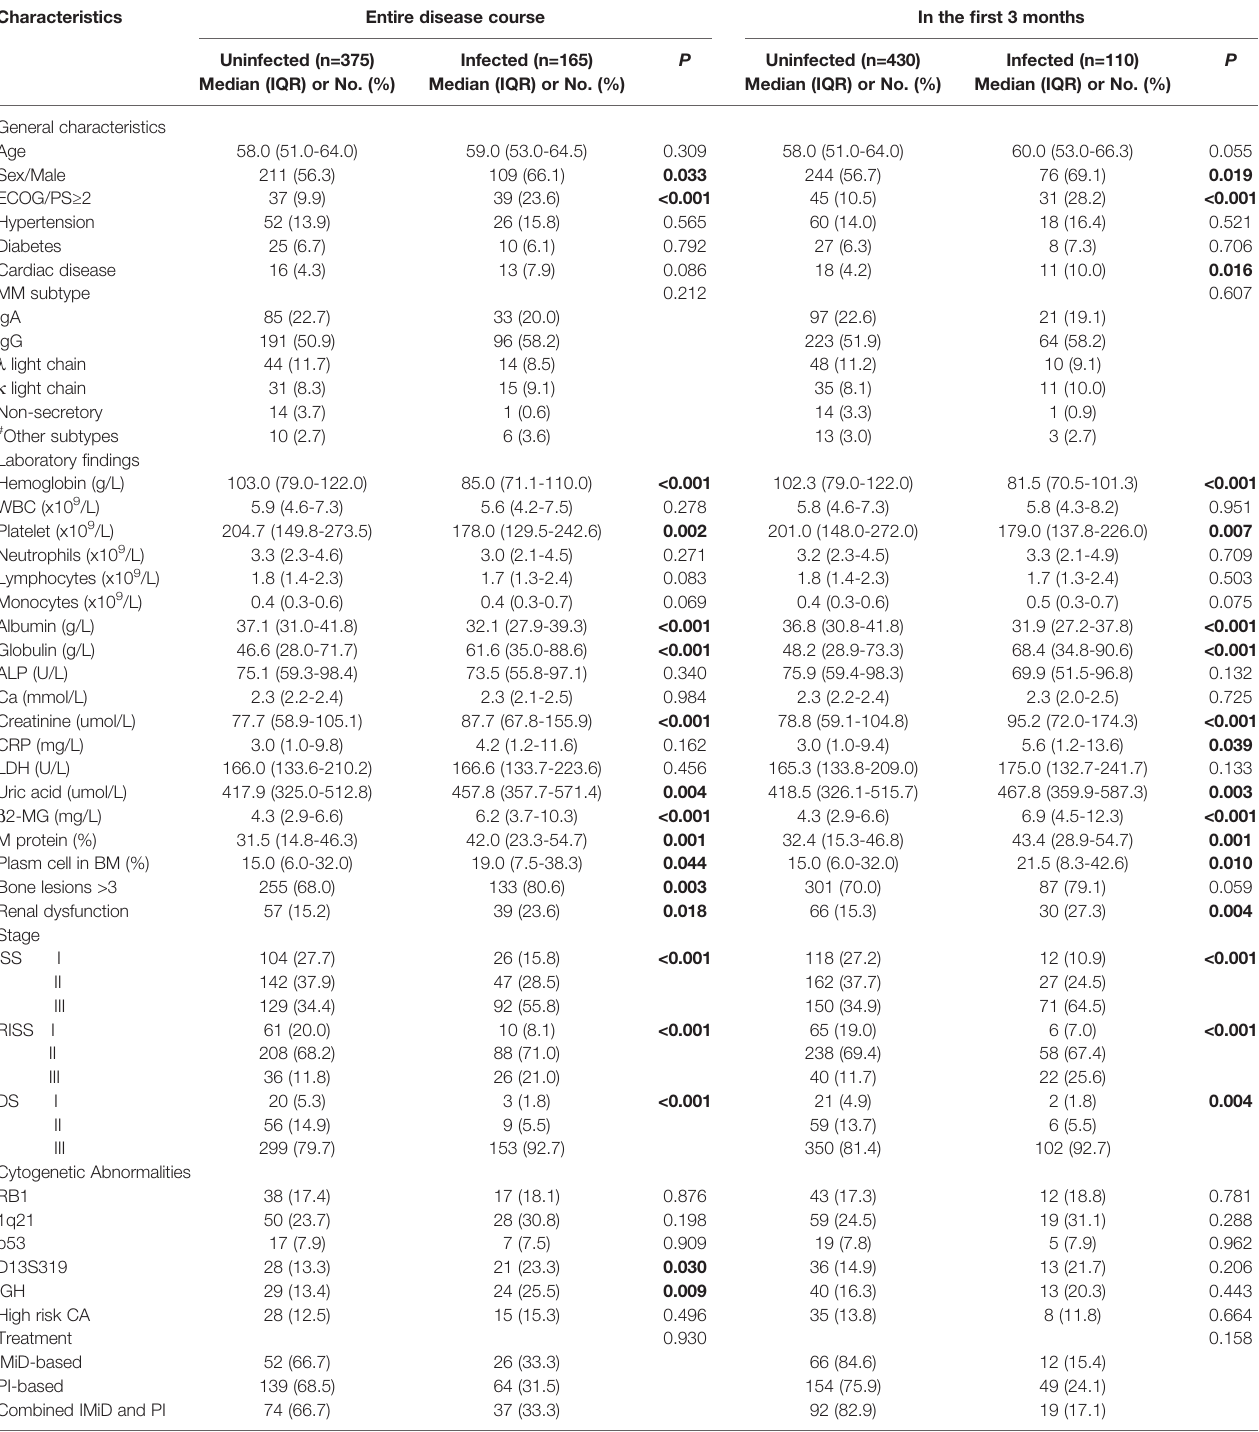
TABLE 1 | Comparisons of baseline characteristics between infected and uninfected patients in total multiple myeloma cases. Characteristics